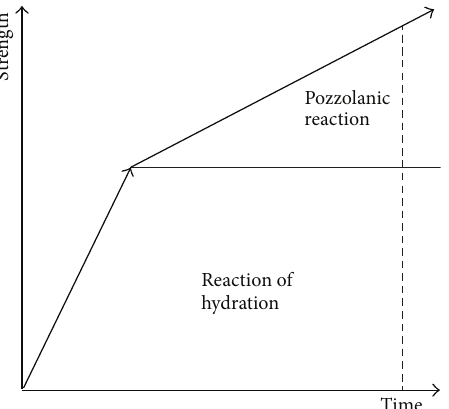
Figure 9: Enhanced strength through ground improvement with cement.